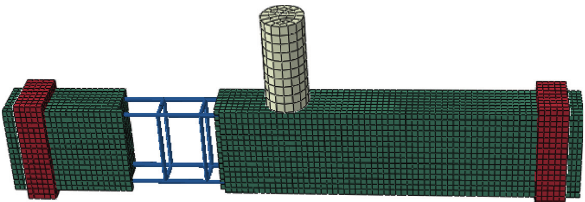
Figure 8: Numerical model diagram.